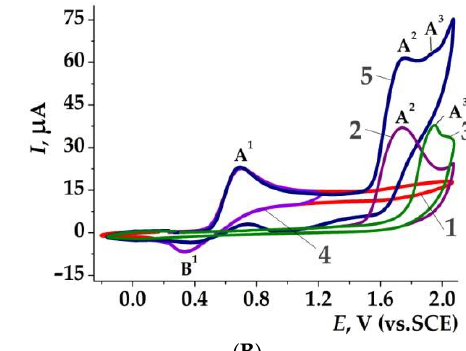
Table 4. C – H An thiocyanation of pyrazole derivatives ( Az‒H ) via (SCN) 2 (approach A) 1 .